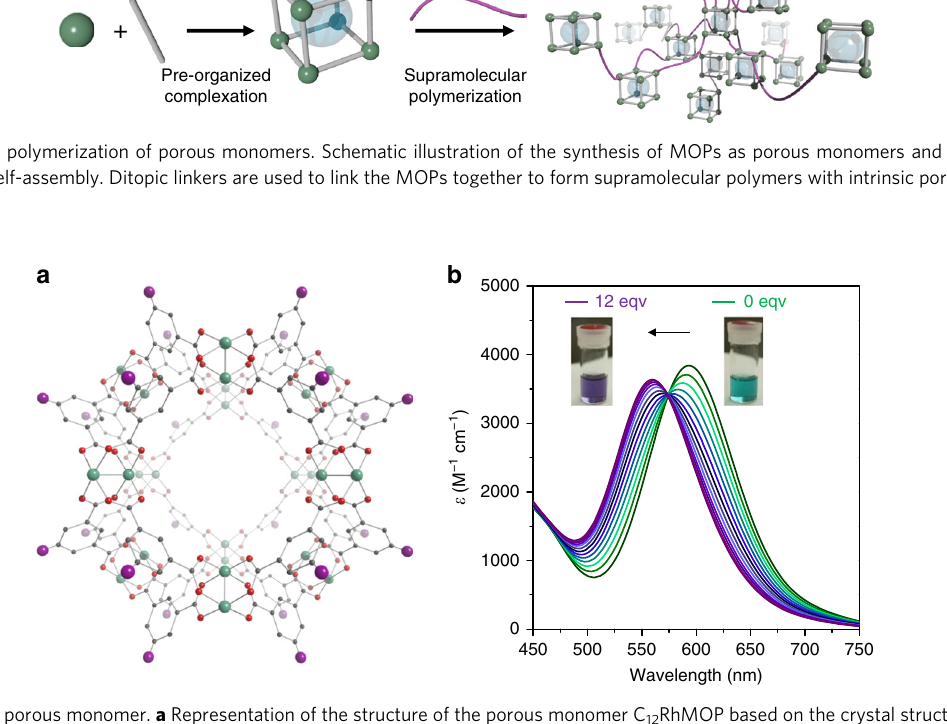
Fig. 2 The C 12 RhMOP porous monomer. a Representation of the structure of the porous monomer C 12 RhMOP based on the crystal structure of the related MOP [Rh 2 (bdc) 2 ] 12 , 18 showing that it is formed by the coordination of rhodium ions (green) to the oxygen atoms (red) of the H 2 bdc-C 12 ligand (gray, with the extended aliphatic chain simpli fi ed as a purple sphere). b UV – vis titration experiments of C 12 RhMOP (0.23 mM) with biz and (inset) a photo of the change in the color of the solution on progression from 0 mol. eq. (green) to 12 mol. eq.